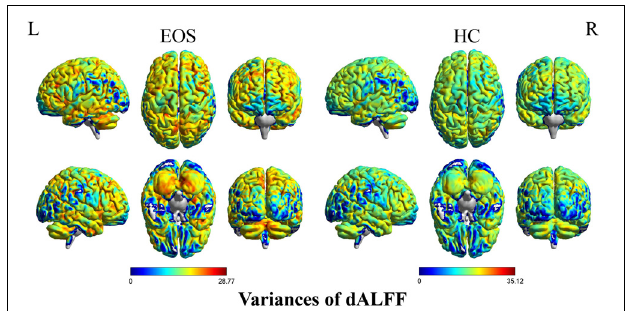
FIGURE 1 | Pattern of dALFF variability in early onset schizophrenia (EOS) patients and healthy controls (HCs). EOS patients and HCs exhibited significant differences in the spatial distribution of dALFF variability. dALFF, dynamic amplitude of low-frequency fluctuations; HCs, healthy controls; EOS, early onset schizophrenia; L, left; R,